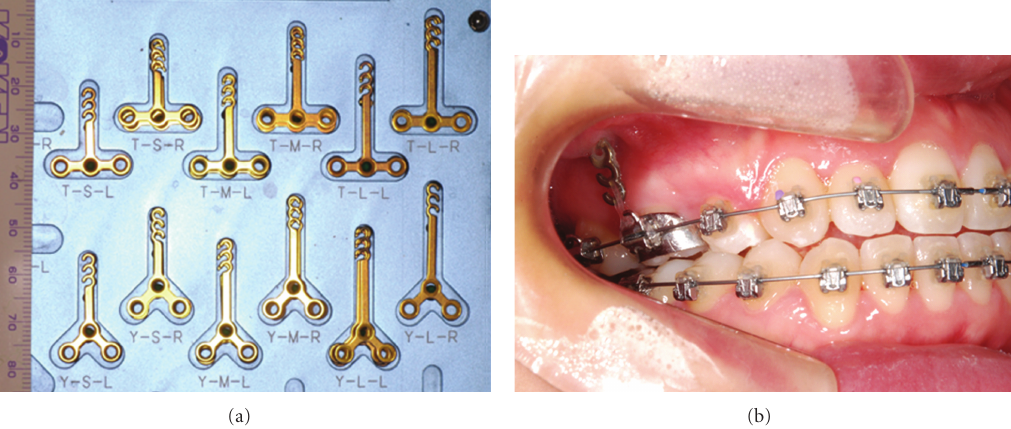
Figure 2: (a) Miniplates, (b) the maxillary right 1st molar was intruded with an elastic chain from miniplate.